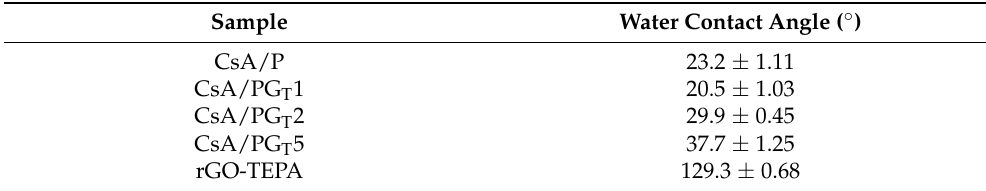
Table 2. Water contact angle of all obtained nanofibrous membranes and